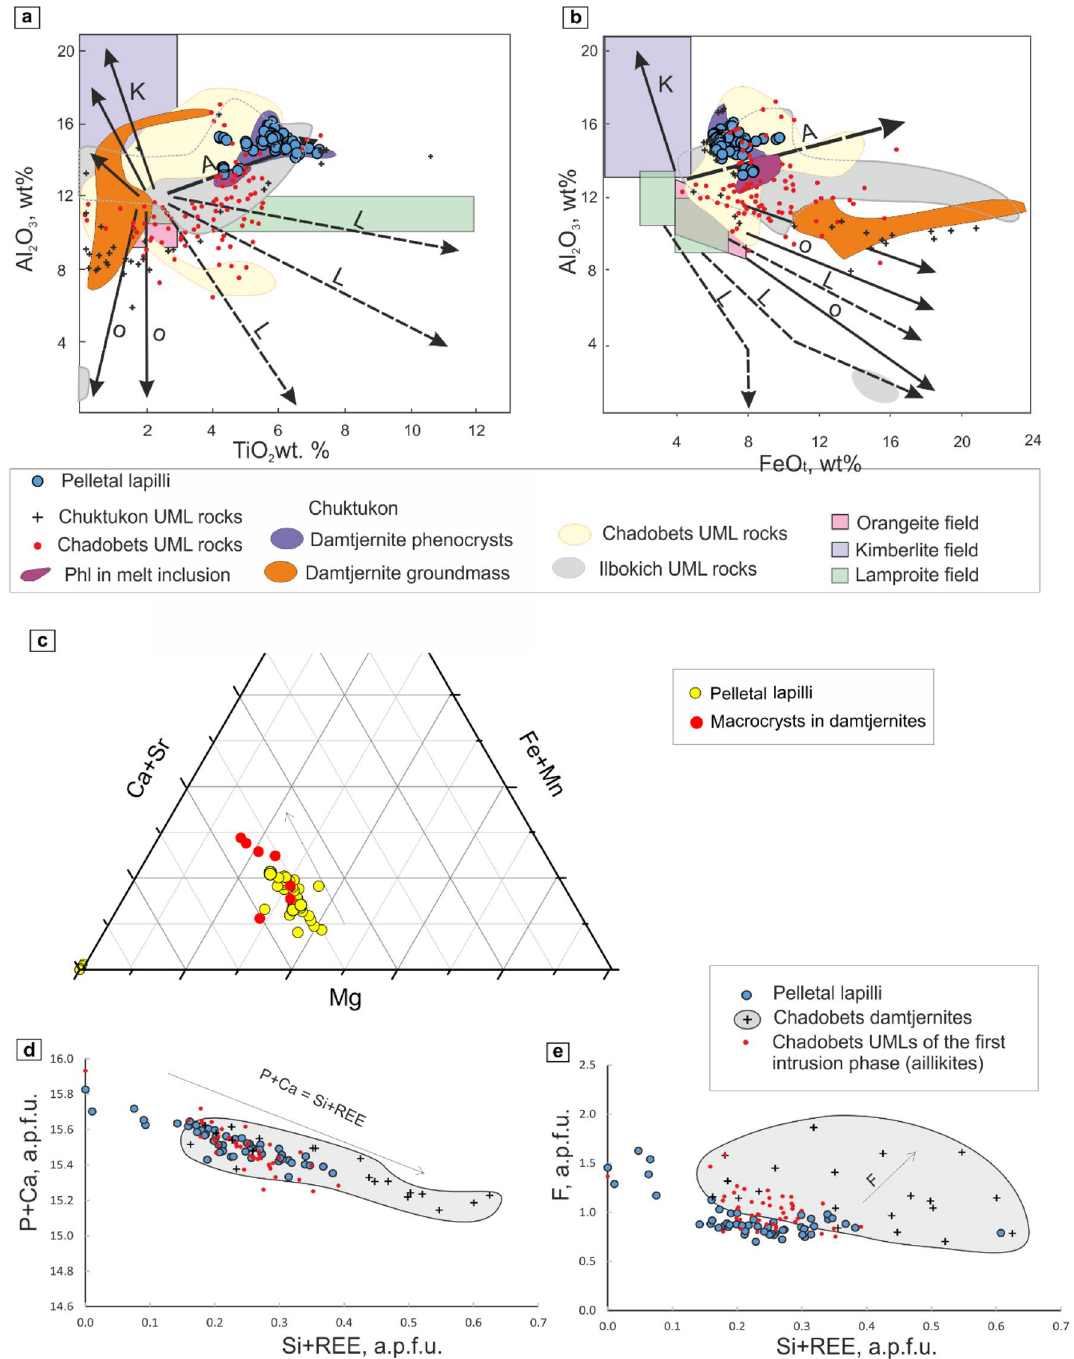
Figure 5. Compositional trends of phlogopites from the Chadobets complexes 7,11,14 . Al 2 O 3 vs. FeOt ( a ) and TiO Ca + Sr vs. Mg vs. Fe + Mn ( c ). The composition of fluorapatite in pelletal lapilli develops a compositional trend with carbonates of damtjernites 7 ; whereas secondary calcite diverges from this trend. Compositional trends of fluorapatites from pelletal lapilli and damtjernites and aillikites of the Chadobets complex; considering the a.p.f.u variations between P + Ca vs. Si + REE ( d ) and F vs. Si + REE ( e